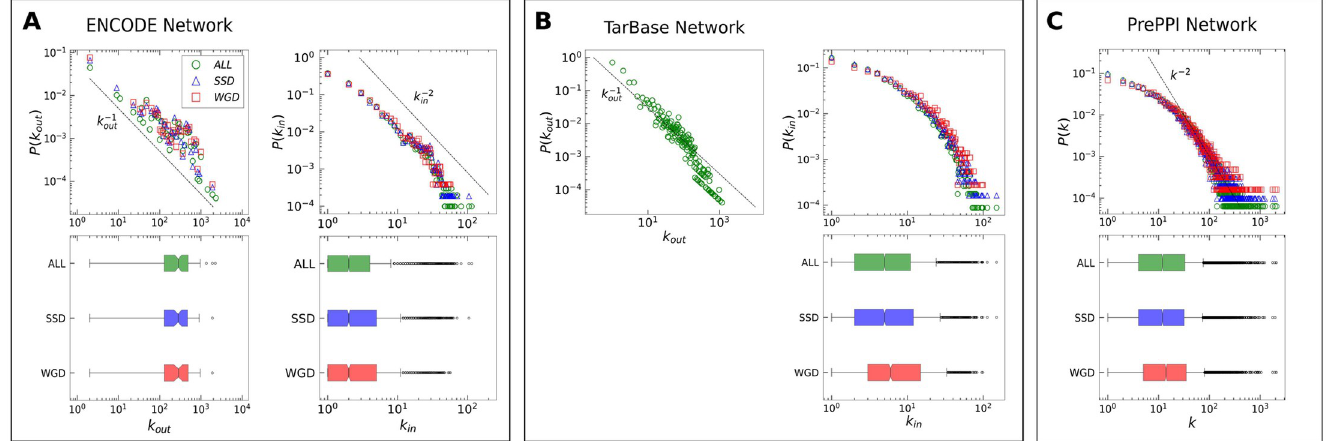
Fig 2. Degree distributions. Indegree (k in ) and outdegree (k out ) distributions of (A) the ENCODE transcriptional regulatory network and of (B) the TarBase miRNA- gene regulatory interactions network, and the degree (k) distribution of (C) the PrePPI protein-protein interactions network. Each degree distribution is shown both as a probability distribution (upper figure) and as a boxplot (lower figure). The global degree distribution of each network is represented in green, while the degree distributions of genes involved in a SSD couple and in a WGD couple are represented in blue and red, respectively. Dotted lines, corresponding to the reported scaling of the degree, are not the result of a fit and are shown as a reference